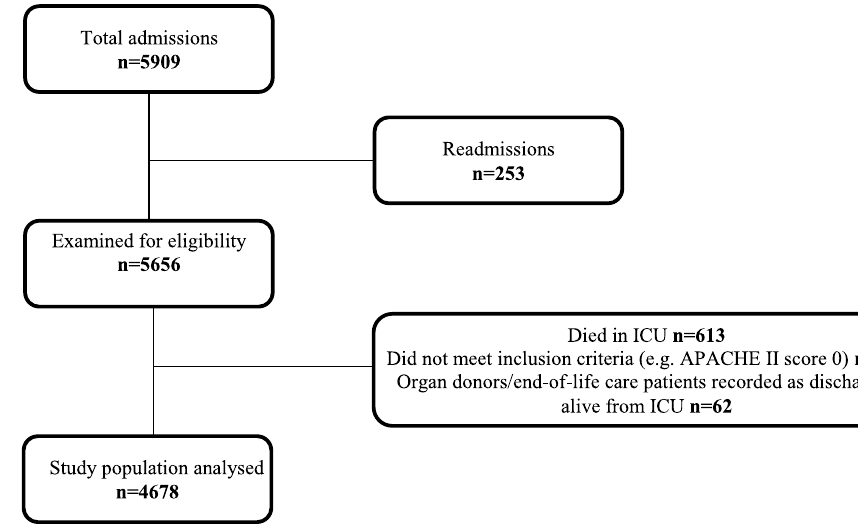
Figure 1. Flowchart describing formation of final study population.